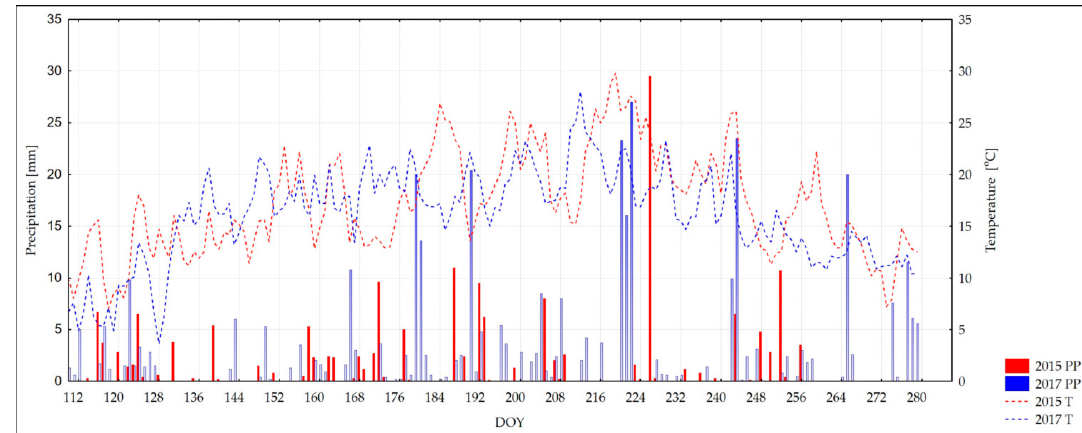
Figure 4. Precipitation (PP) and temperature (T) for growing seasons 2015 and 2017—meteorological station Smolice.